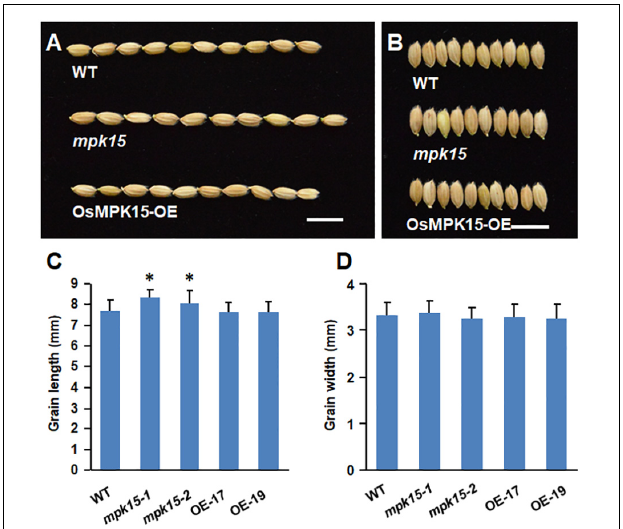
FIGURE 8 | Grain length and width of the WT, mpk15 mutant, and OsMPK15-OE lines. (A,B) The phenotype of grain length and width from the WT, mpk15 mutant, and OsMPK15-OE lines. Bars indicate 10 mm. (C,D) Statistics of grain length and width ( n = 300), respectively. ∗ P ≤ 0.05; ∗∗ P ≤ 0.01 (Student’s t